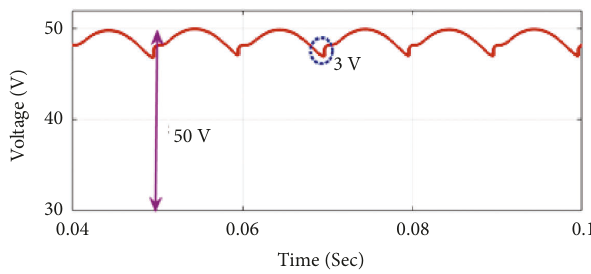
Figure 7: Capacitor ripple voltage.